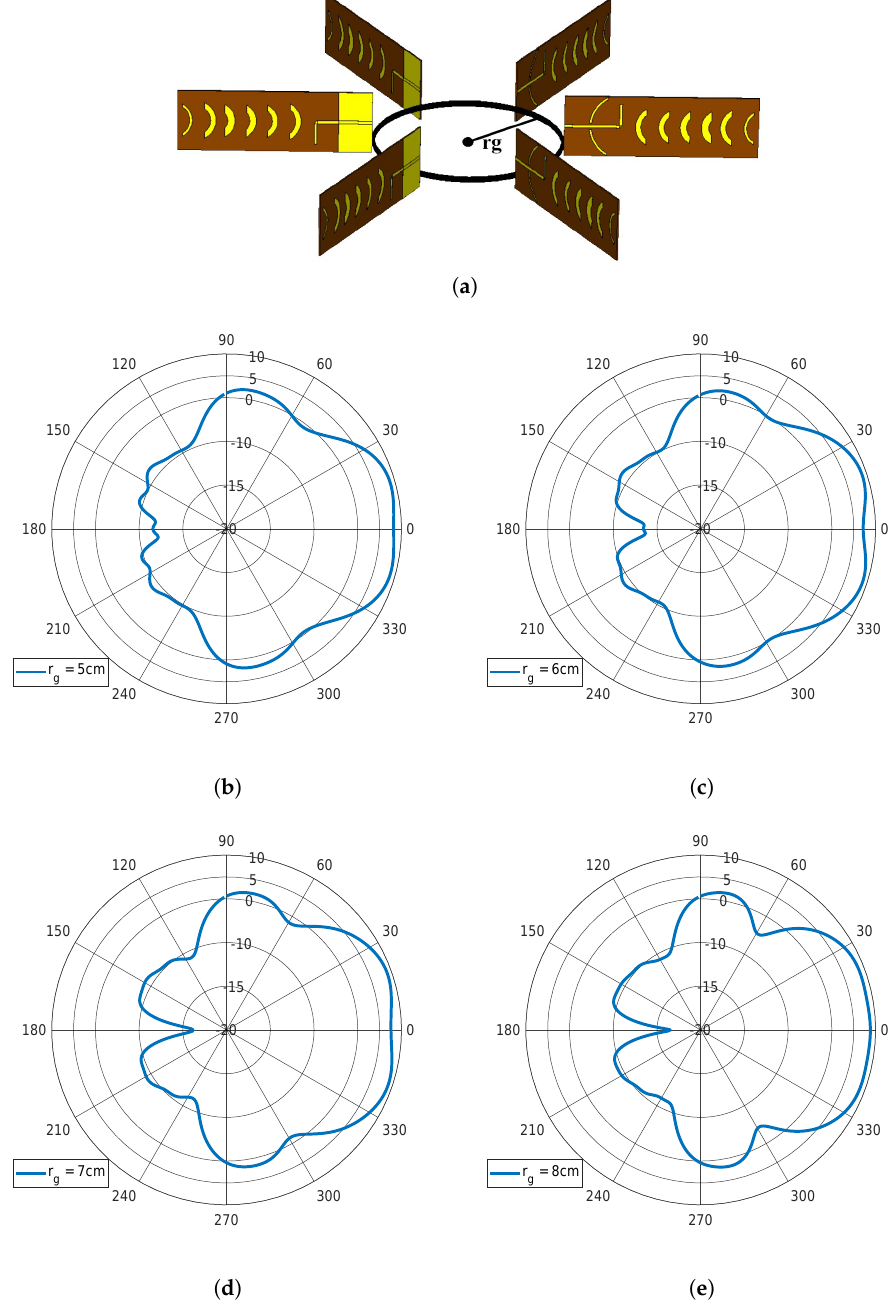
Figure 4. Study of the impact of the adjacent antennas in radiation performance: ( a ) simulation model in CST MWS; simulated radiation patterns in azimuth plane for: ( b ) r g = 5 cm, ( c ) r g = 6 cm, ( d ) r g = 7 cm and ( e ) r g = 8